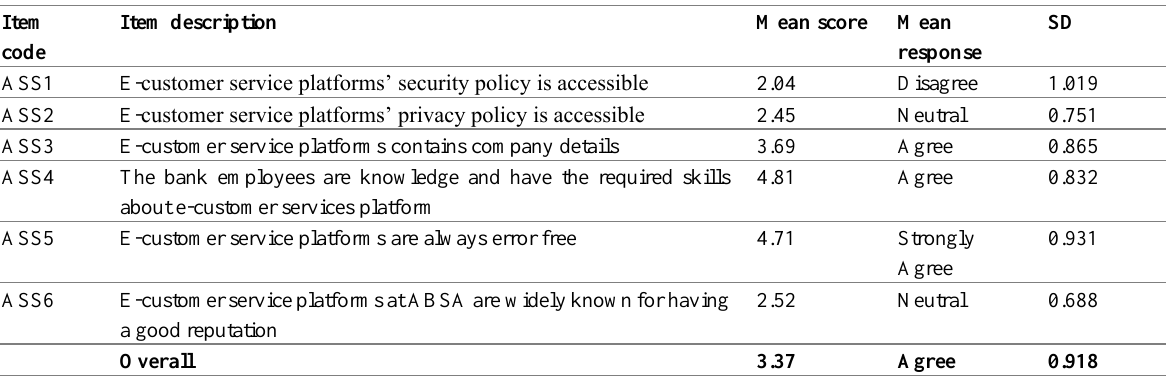
Table 5: Descriptive Statistics for